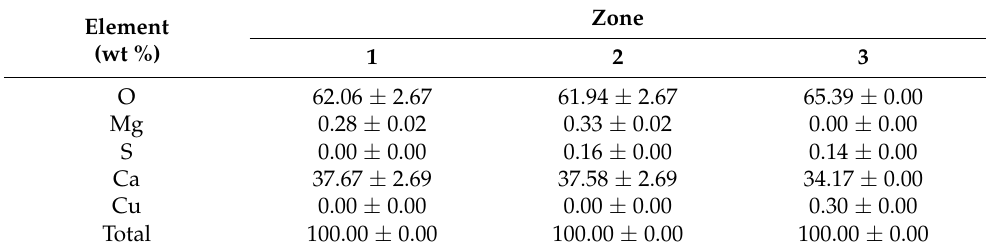
Table 5. EDS microanalysis (wt %) of the areas marked in Figure 5b (MRM powder). Element